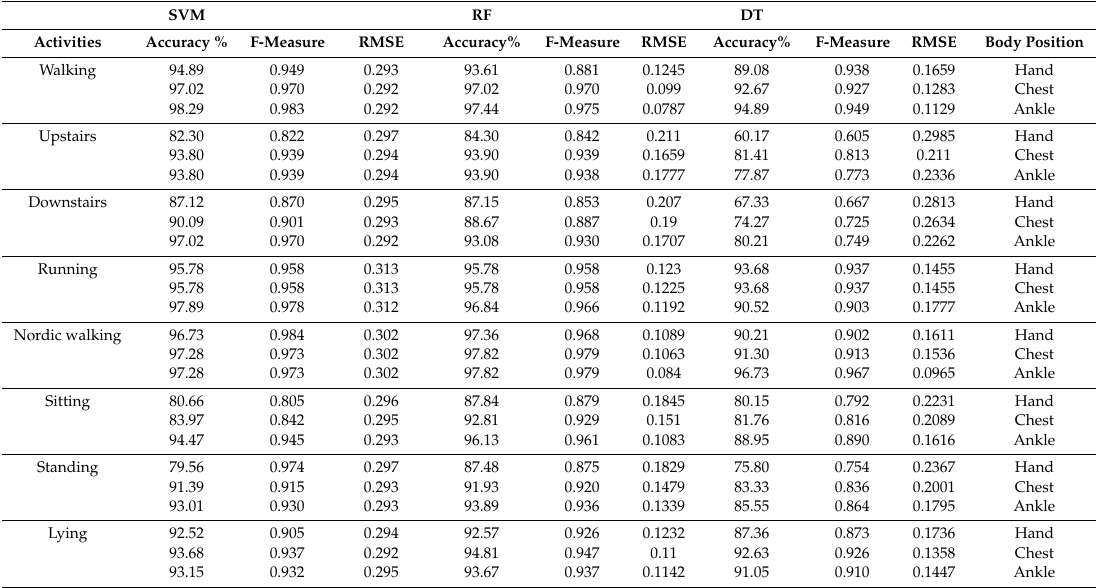
Table 5. Results of user recognition based on performance metrics for selected activities in the Physical Activity Monitoring dataset